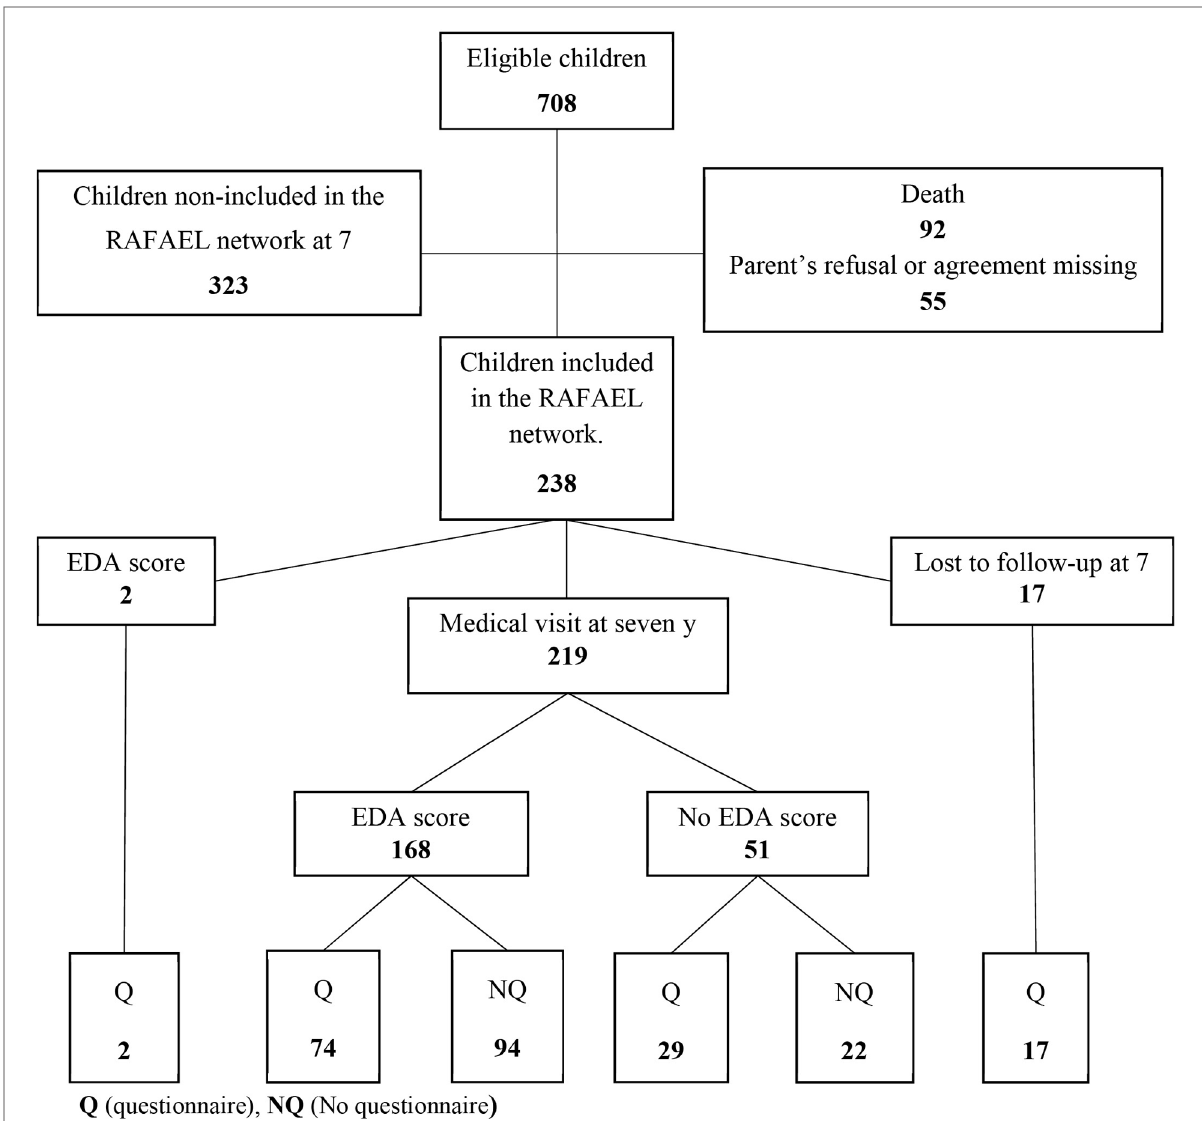
FIGURE 1 Flowchart of children born before 33 weeks and followed up in the RAFAEL network from 2010 to